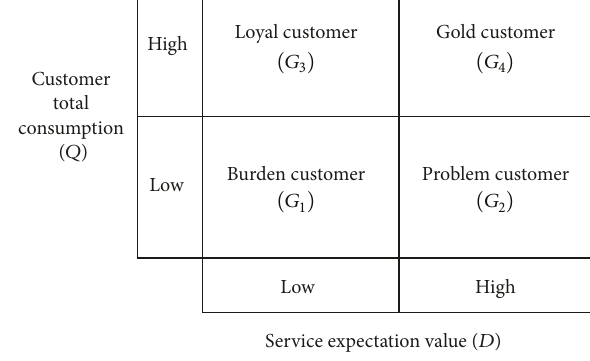
Figure 5: Customer market